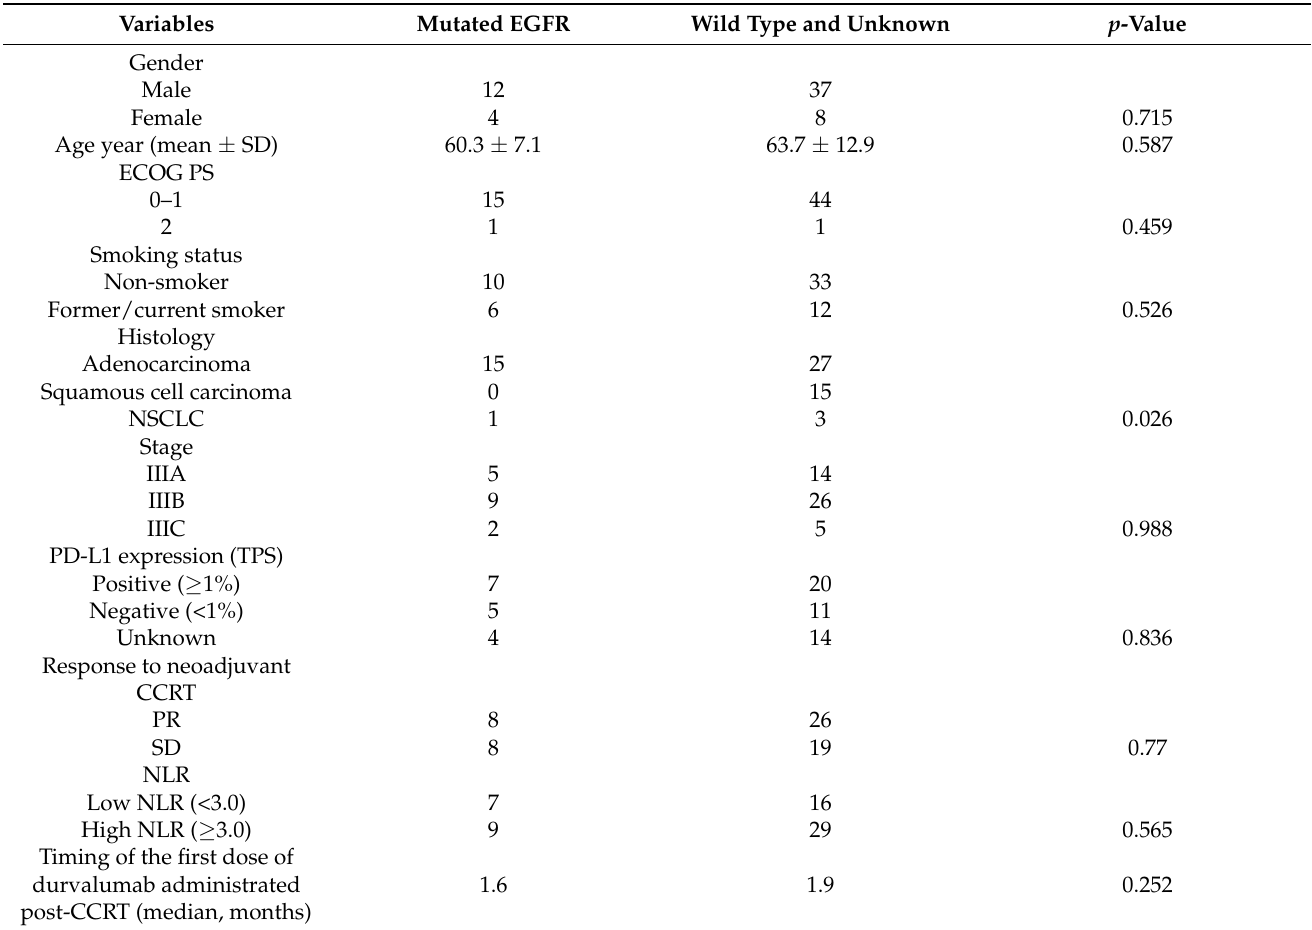
Table 3. Comparison of characteristics between patients with different EGFR mutation